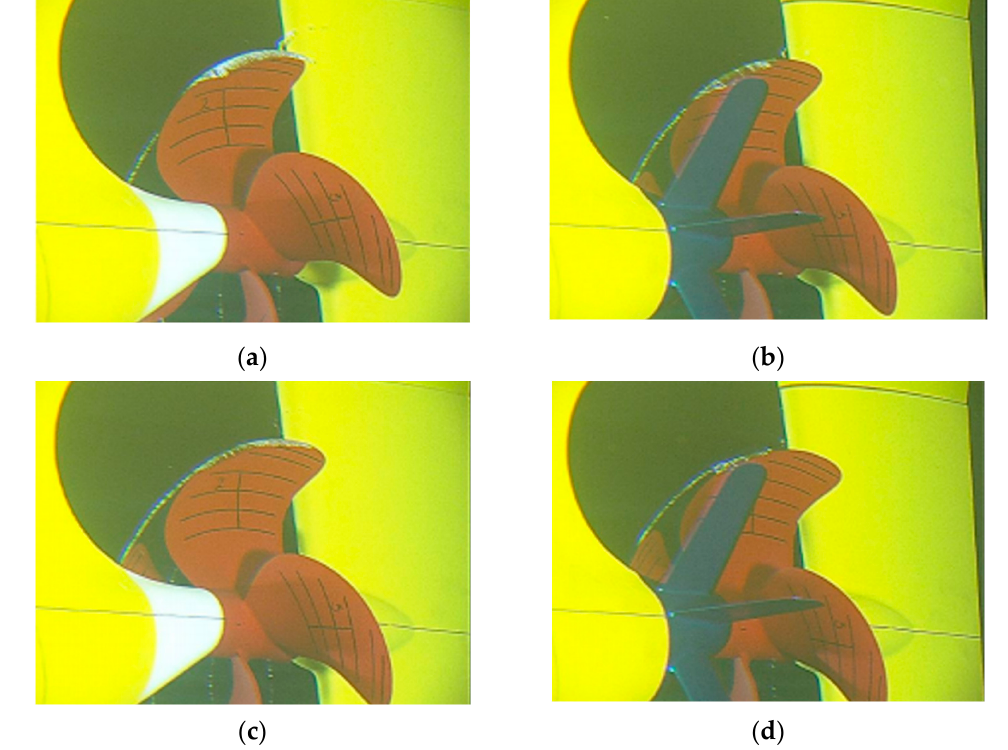
Figure 18. Photos of cavity for Bare and with ESD ( a , b ) θ = 0 ◦ ; ( c , d ) θ = 10 ◦